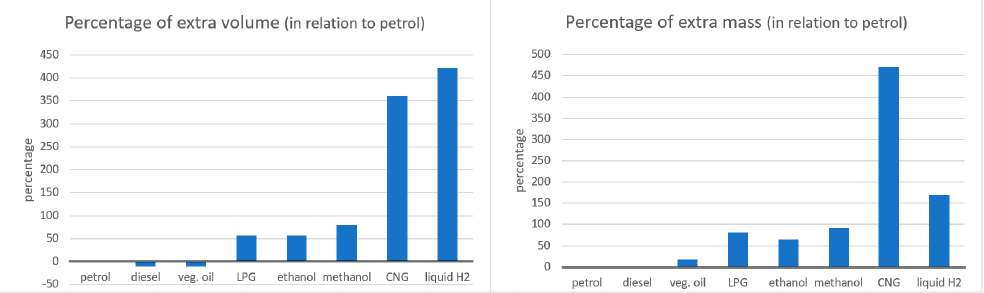
Figure 1. Percent increase of volume and mass of fuel tanks in relation to petrol (55 L tank), [25].